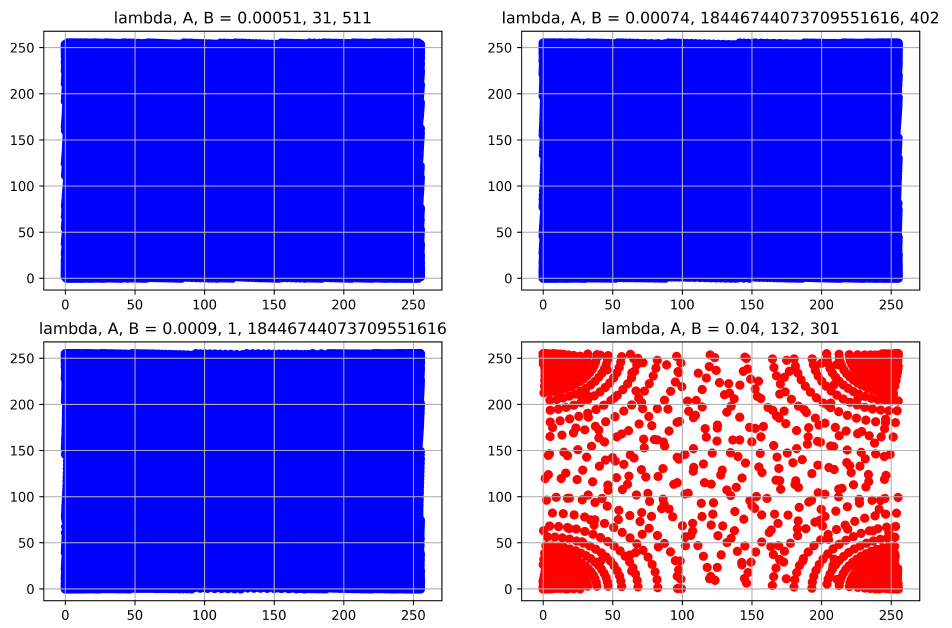
Figure 4. The effects of parameters’ values on the security of the output chaos. The values of λ greatly affects the output chaos in that a random enough chaos can be generated only if λ ∈ [ 0.0005,0.0009 ] . After the R, G, and B channels of an input frame have been mixed with R chaos , G chaos , and B chaos , respectively, their ciphers are shuffled in a 2D block size of 32 × 32 using the improved version of the Fisher–Yates [53] algorithm to increase the degree of diffusion and confusion to make it next to impossible for crypto-analysts to perform any security parameter analysis on a cipher to obtain clues about its corresponding plain frame. This scrambling module is then incorporated to the simple motion-detection method portrayed in Algorithm 1 at the edge camera and the scrambling process is performed as briefly described in Algorithm